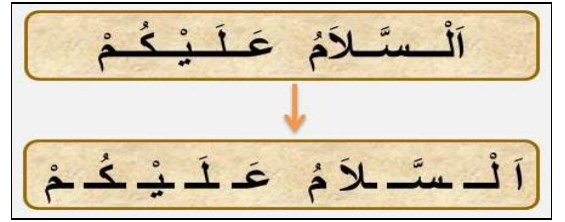
Table 2. Arabic script with diacritics